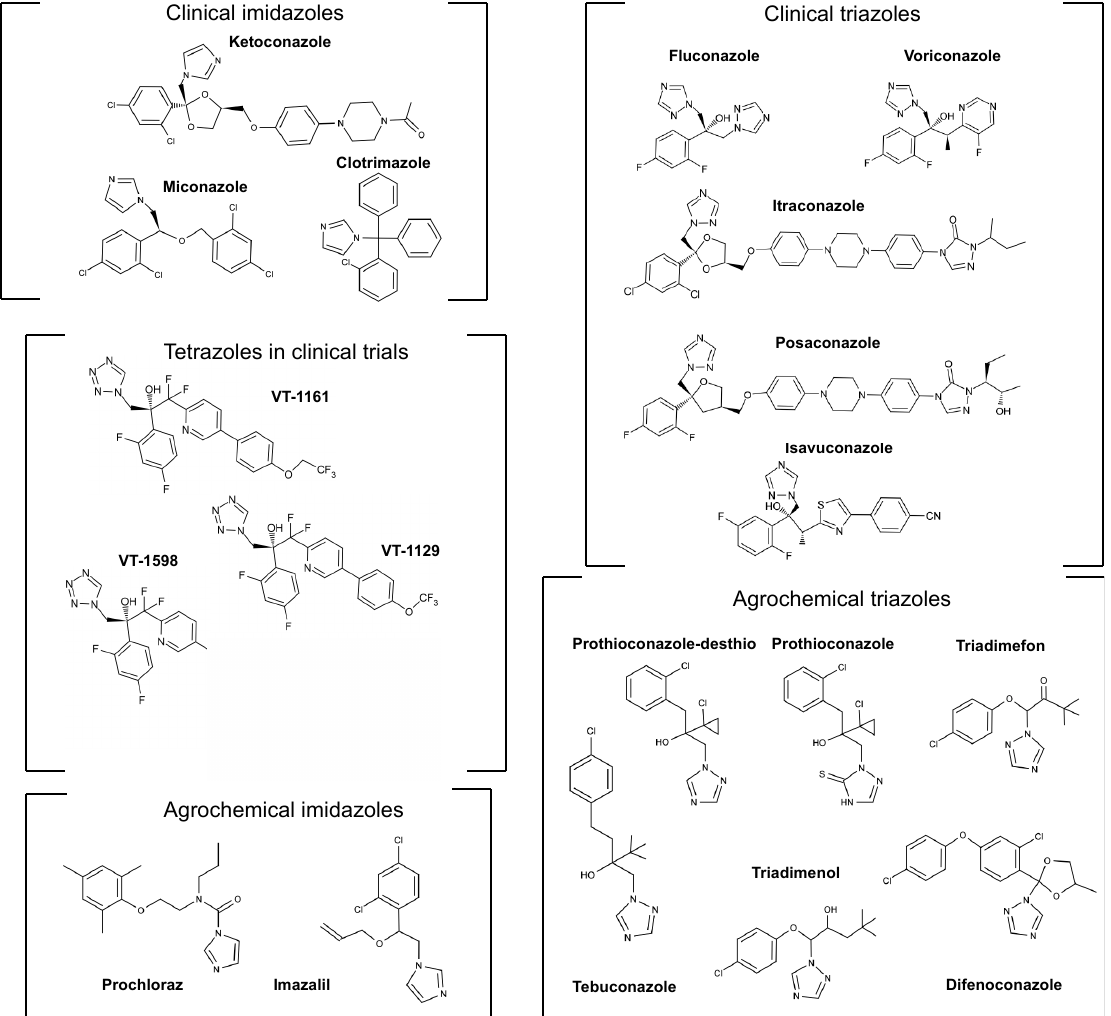
Figure 1. Representative azole drugs, agro-chemicals and compounds in clinical development. The roles of the fungal-specific sterol ergosterol and the regulation of its biosynthesis were reviewed recently [56]. Ergosterol is the main sterol found in fungal membranes. It is involved in the maintenance of membrane structural integrity, fluidity and permeability, and the activity of membrane bound enzymes. It is required for cell proliferation, may have a role in maintenance of mitochondrial DNA and is important for stress adaption including to the effects of temperature, low sugar, alcohol and oxidative stress. In animals the primary sterol is instead cholesterol, which acts as a precursor for vitamin D, bile acids and steroid hormones, while in plants the phytosterols are required for growth and differentiation and are involved in stress adaption. Clearly, inhibitors of fungal CYP51 should be specific and not inactivate host CYP51s or other cytochrome P450 enzymes, although the